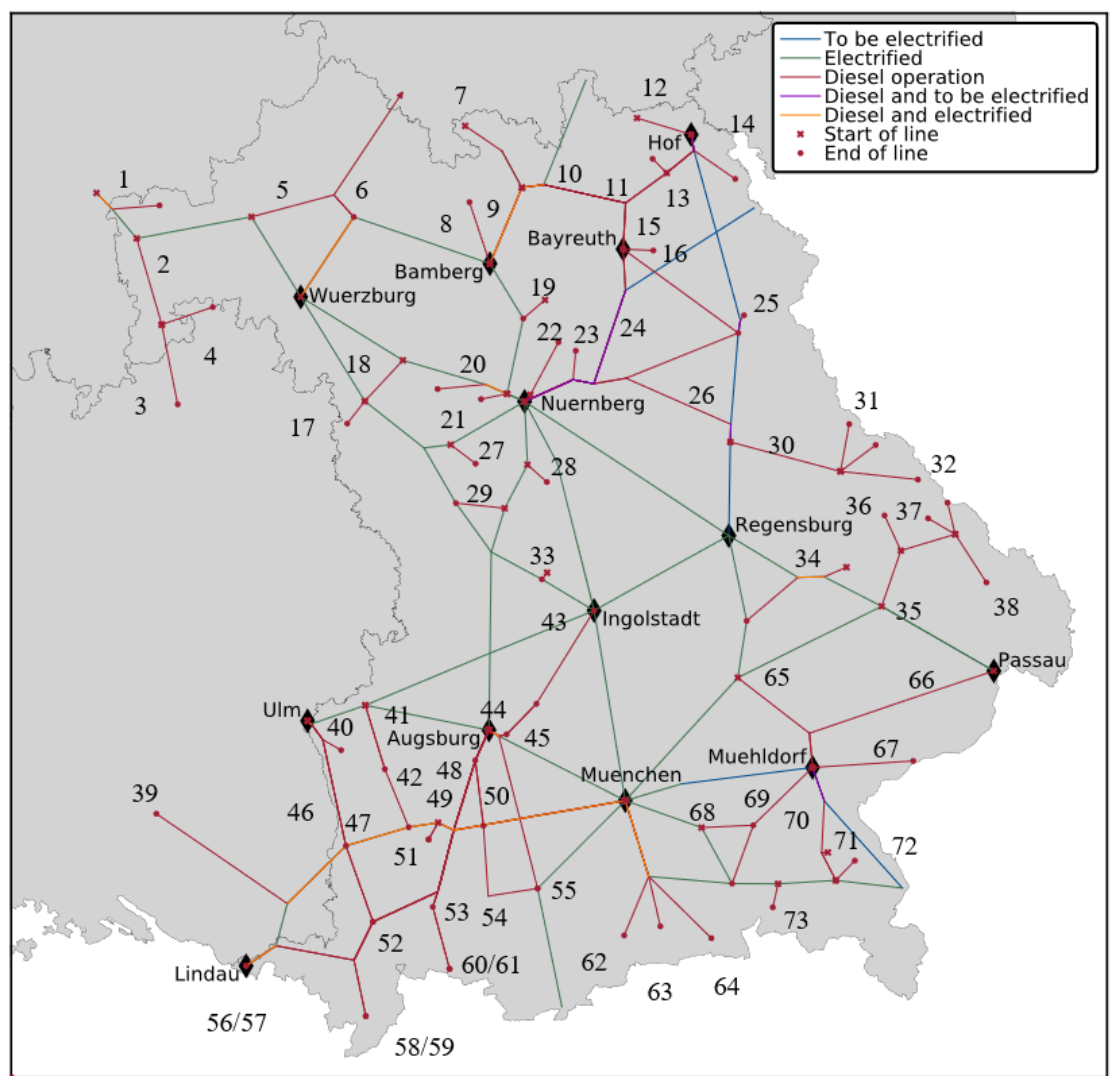
Figure 1. Map of diesel operated lines and overlap with current and future electrification Lines are defined by state-owned and -funded companies. Since lines are subject to changes,